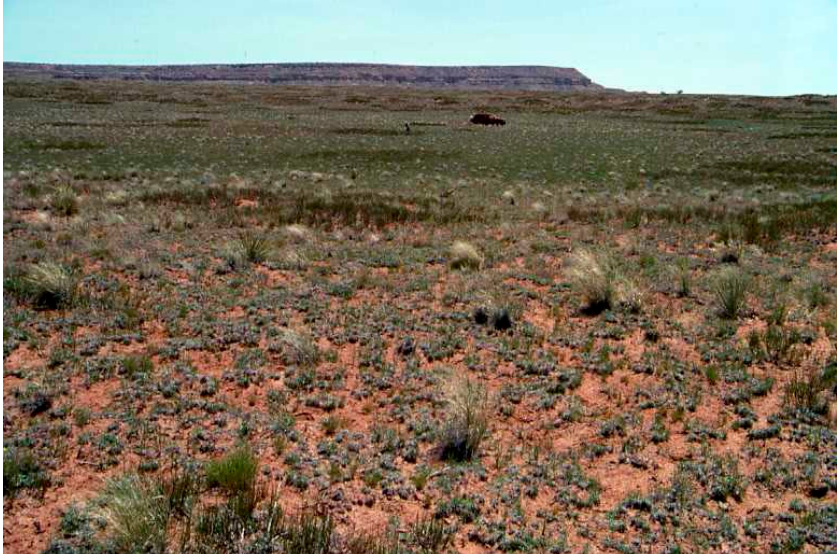
Figure 8. View towards the east from the central portion of the Moenkopi Plateau. Howell Mesa is the long, flat-topped landform on the horizon. The photo is taken from the low crest of a stabilized dune. The small, low bunch grasses in the foreground are Bouteloua gracilis and Pleuraphis jamesii . Moderately heavy use of the site in the previous year has considerably reduced the potential canopy coverage of these grasses. The tall, light-colored bunch grass is Oryzopsis hymenoides . The wide, dark green patches in the midground and on slopes of the next linear dune are clonal patches of Ephedra . The interdune area where the vehicle is located is dominated by a relatively dense cover of Pleuraphis jamesii. Photo by J. McAuliffe, 13 May 1992.